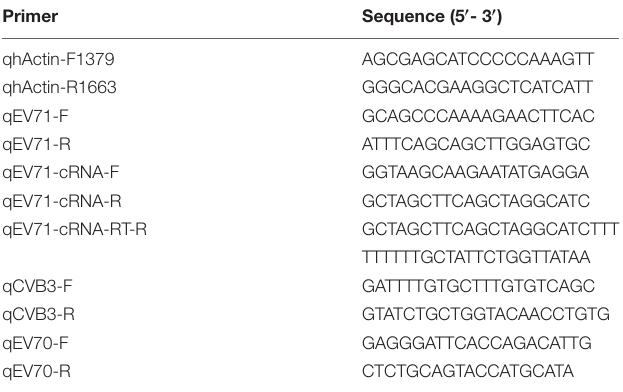
TABLE 1 | Primers used for